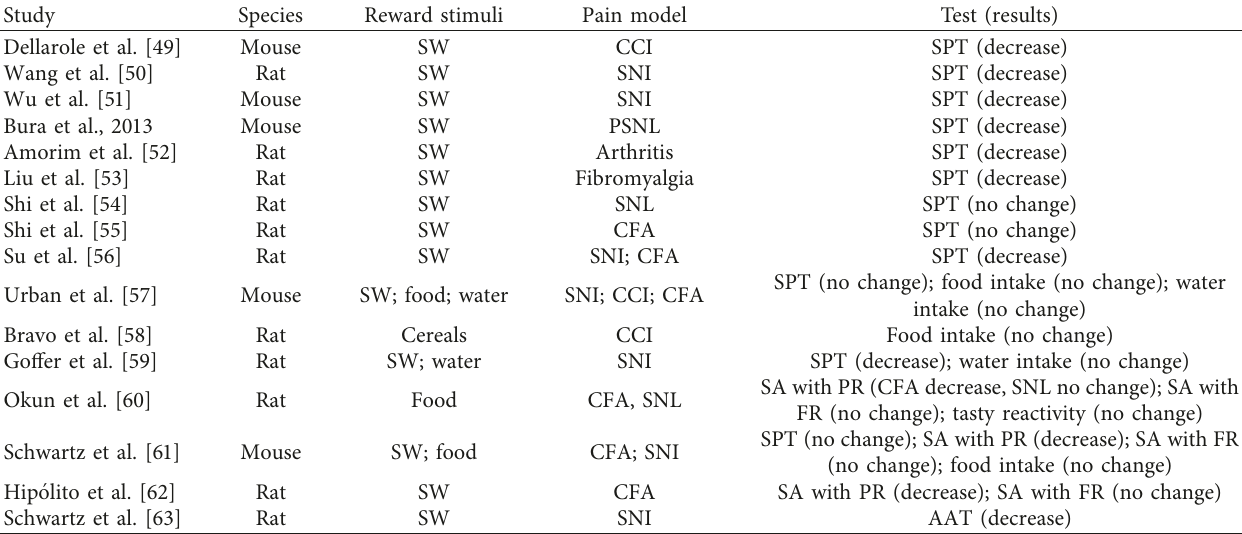
Table 2: Reward-related behaviors in animals with chronic